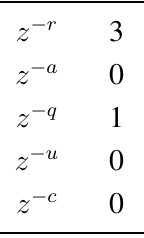
Table 3. Delays associated with the arithmetical operations used in the two